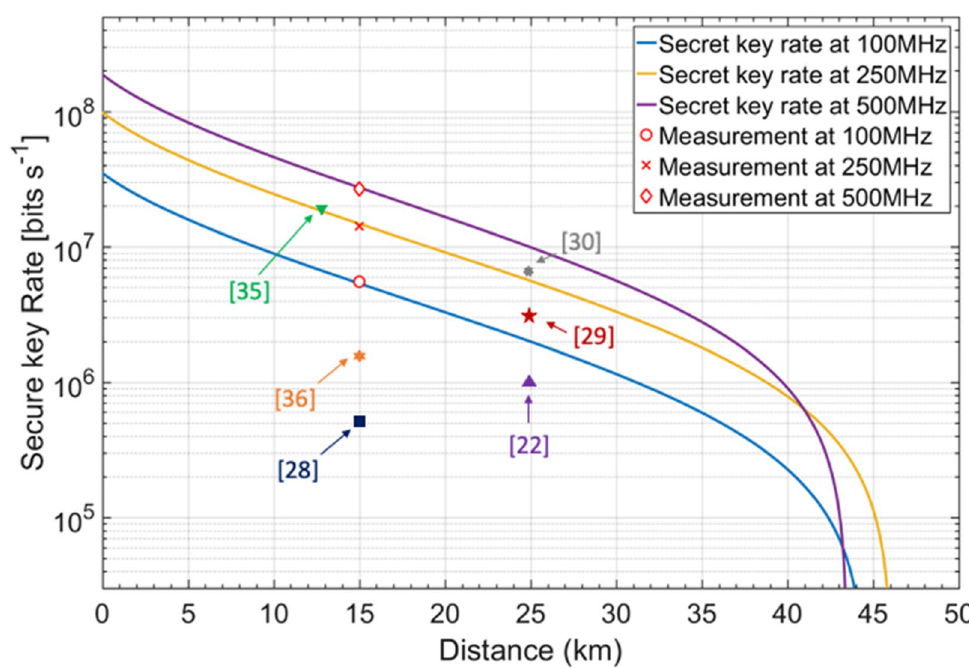
Figure 5. The secret key rate performance of our LLO CVQKD system. The secret key rate as a function of transmission distance at 100 MHz, 250 MHz and 500 MHz repetition rates, together with the average experimental measurements of excess noises over a 15 km SMF fibre. The red circle, cross and diamond represent the estimated key rate of 5.5 Mbps, 14.2 Mbps and 26.9 Mbps at 100 MHz, 250 MHz and 500 MHz repetition rates respectively. The data block size is 10 7 . V A